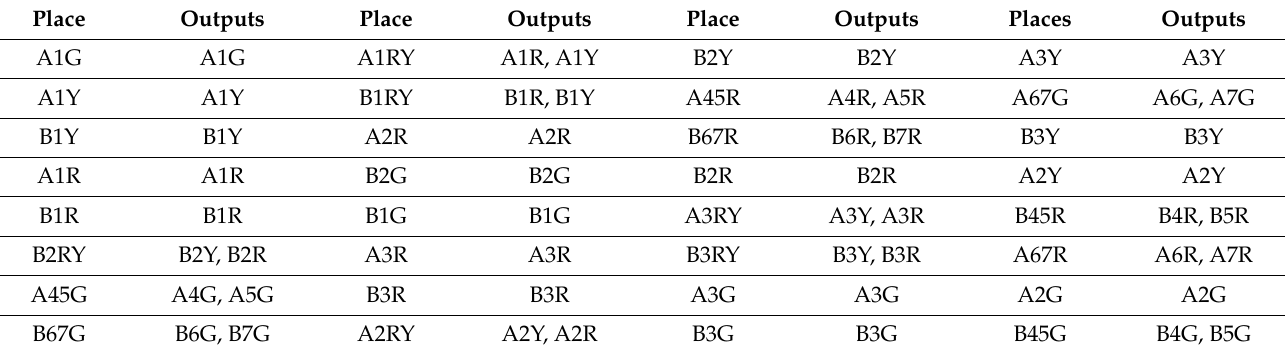
Table 1. Association between places and output signals.